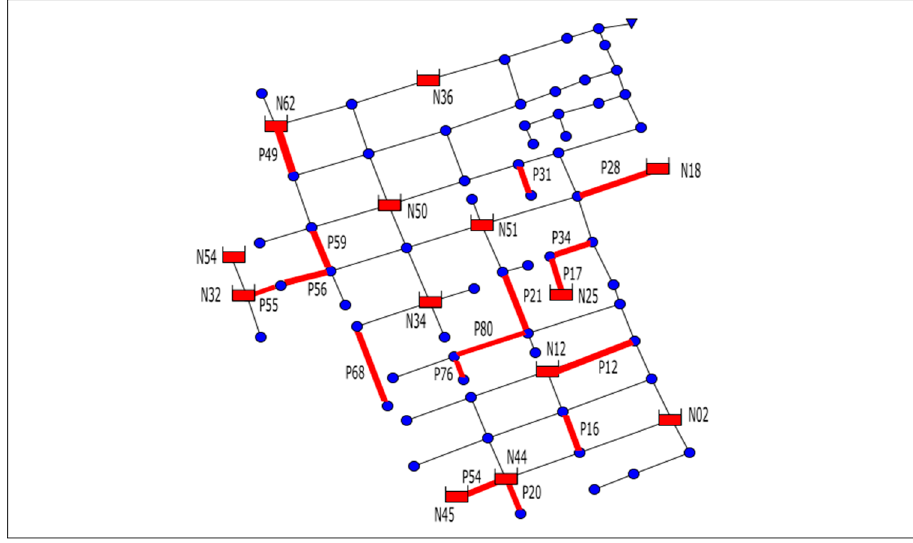
Figure 8. Representation of storm tanks installed and pipes to substitute according to model SSR 2 zero-flooding solution.